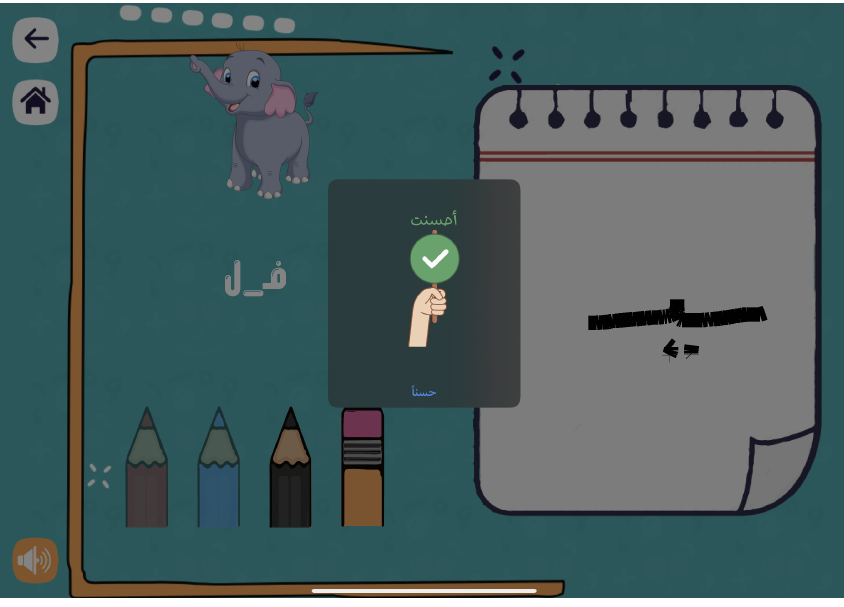
Figure 5. Feedback interface.